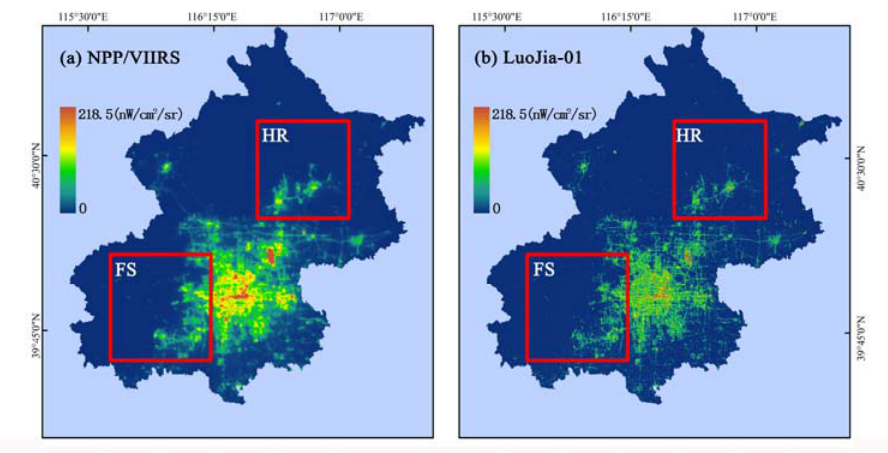
Figure 6. Maps depicting the validation areas (HR and FS) and NTL datasets. ( a , b ) Overall spatial distributions of the NPP ‐ VIIRS NTL data (September 2018) and LuoJia1 ‐ 01 NTL data (September 2018).